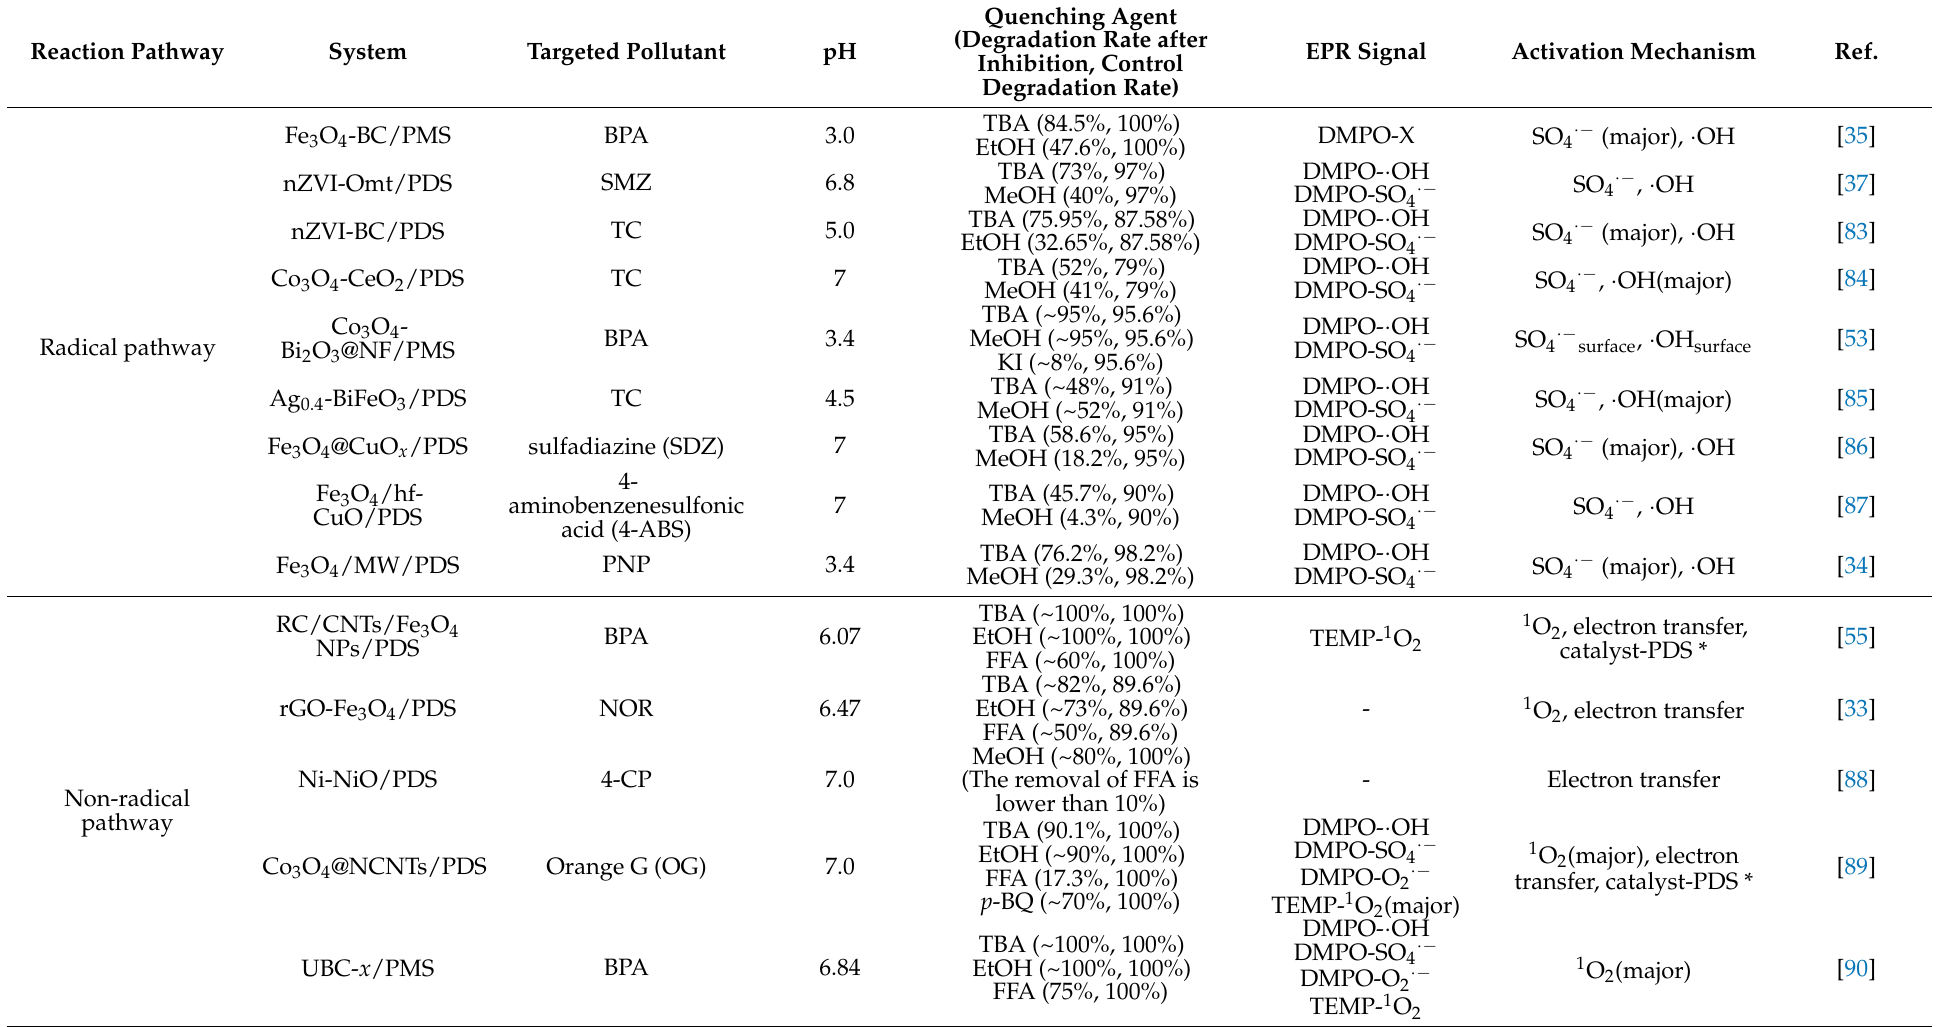
Table 2. Active species involved in the reaction